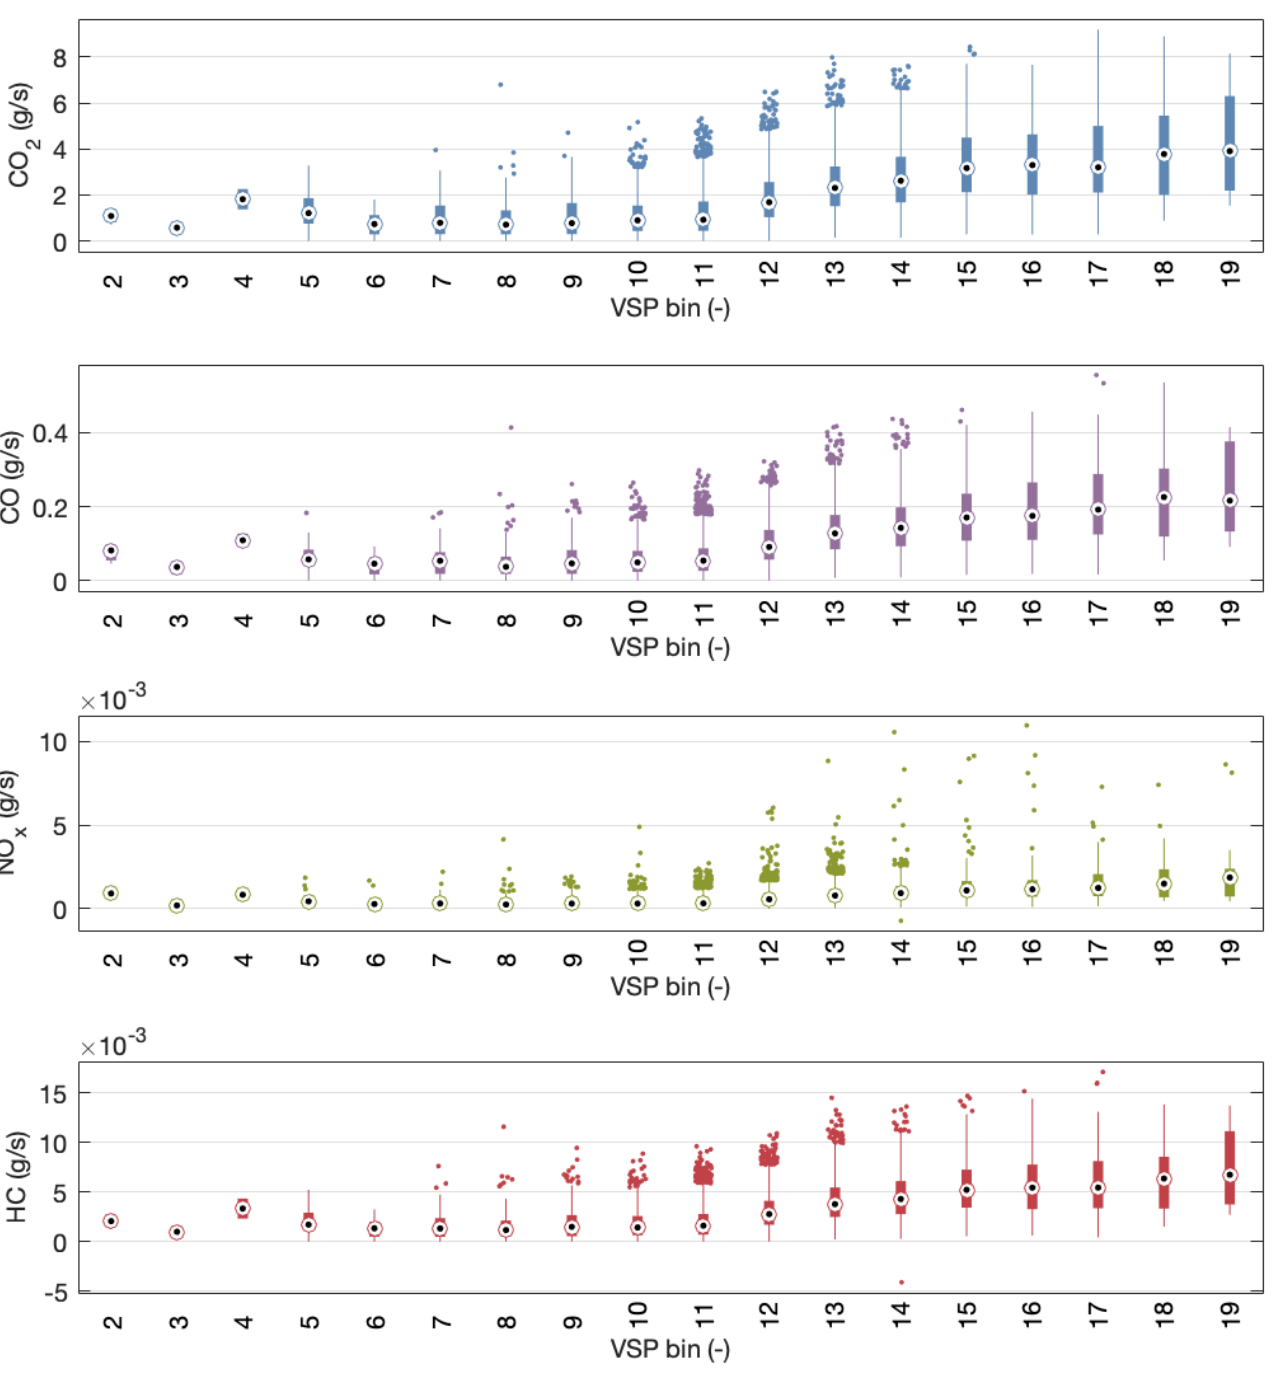
Figure 12. Box plot of mass flow of emissions for test carried out with gasohol